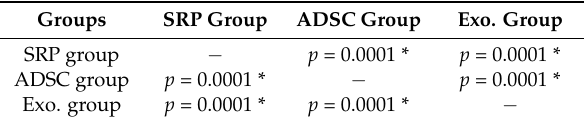
Table 3. Pairwise comparison of mean area % values of newly formed tissues for the studied groups after 2 weeks (post hoc Tukey test).